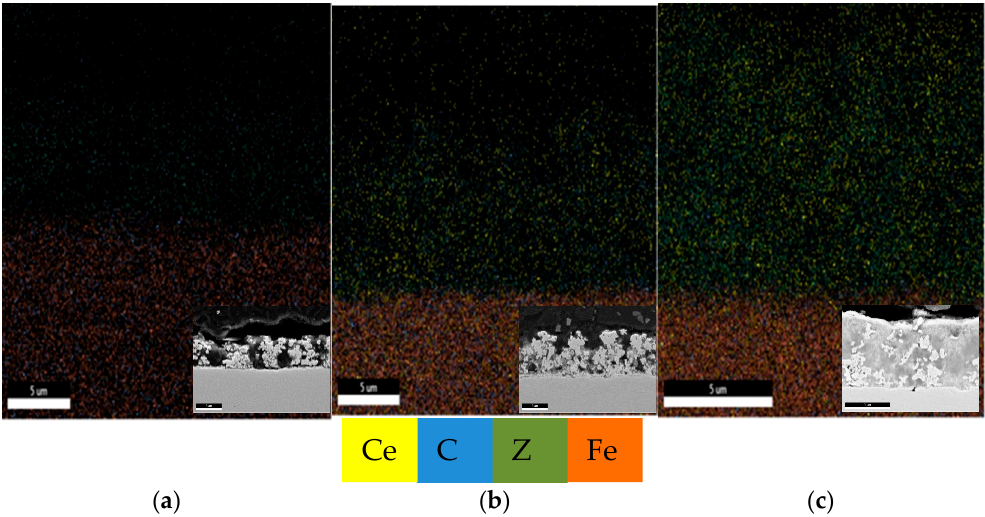
Figure 8. Element mapping of ( a ) Zn-Co, ( b ) Zn-Co-CeO 2 (CeO 2 powder) and ( c ) Zn-Co-CeO 2 (CeO 2 sol) cross sections.